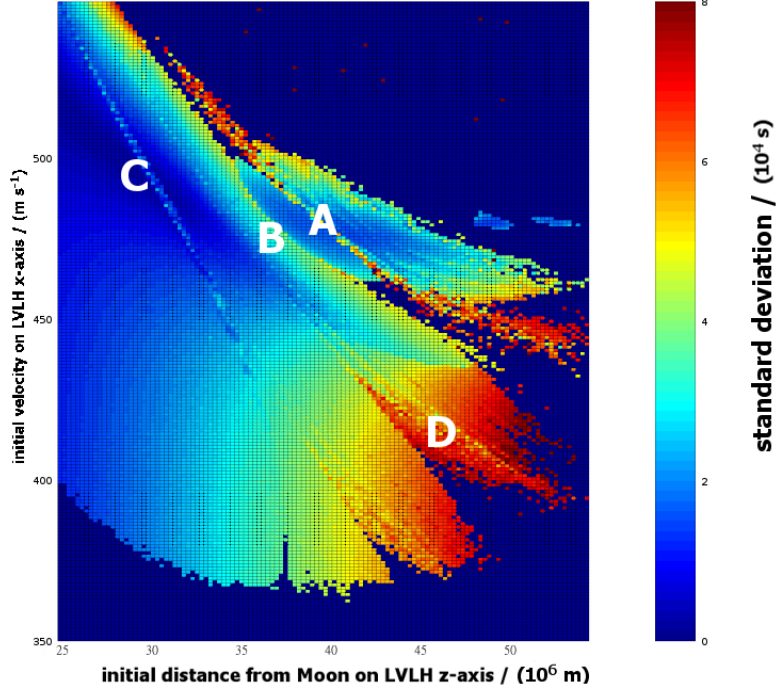
Figure 18. Replica of Figure 16 identifying regions of interest (A–D) as discussed in this